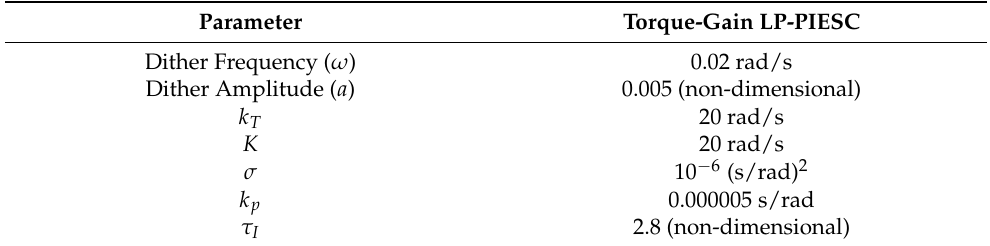
Table 3. LP-PIESC Parameters of NREL 5 MW Region 2 controller. See Equations (6)–(12). Parameter Torque-Gain LP-PIESC Dither Frequency ( ω